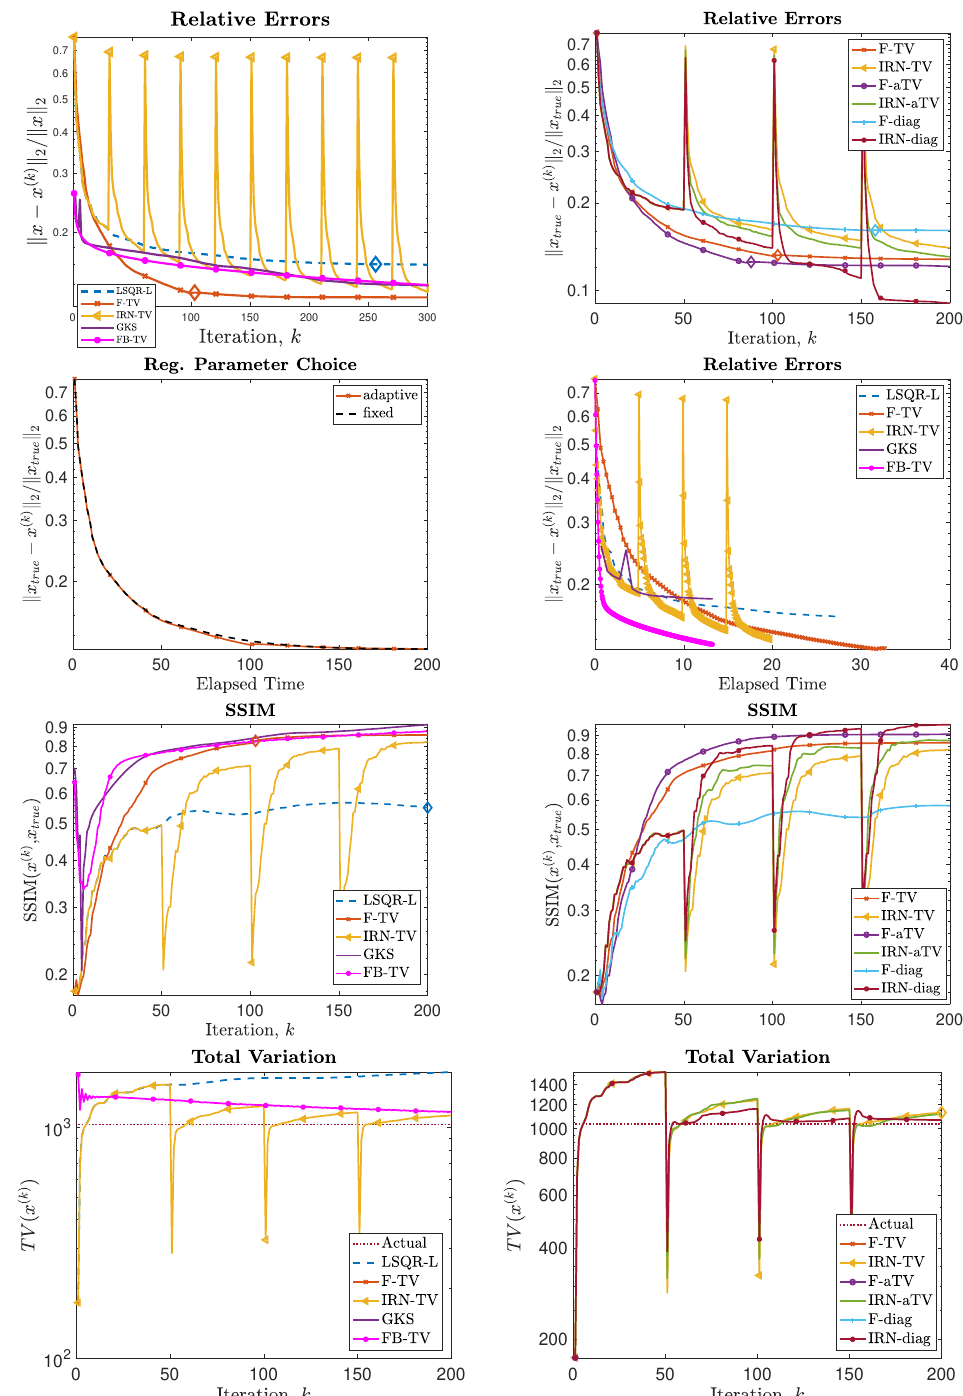
Figure 5. Experiment 1, with N = 256 . ( Top row ): History of the relative error norms, com- paring F-TV, F-aTV, F-diag, FBTV, and LSQR-L. Diamond markers indicate the iteration at which the stopping criterion (31) is satisfied. ( Second row , left ): history of the relative error for the new F-TV method implemented with iteration-dependent regularization parameter λ ( k ) , k = 1,2, . . . , set according to the discrepancy principle (30), and fixed regularization parameter λ = λ ( 200 ) . ( Second row , right ): progress of the F-TV, LSQR-L, FBTV, GKS and IRN-TV relative errors versus elapsed computational time. ( Third row ): SSIMs values versus iteration number for the methods listed in Table 1. ( Bottom row ): history of the total variation of the reconstructions computed by each